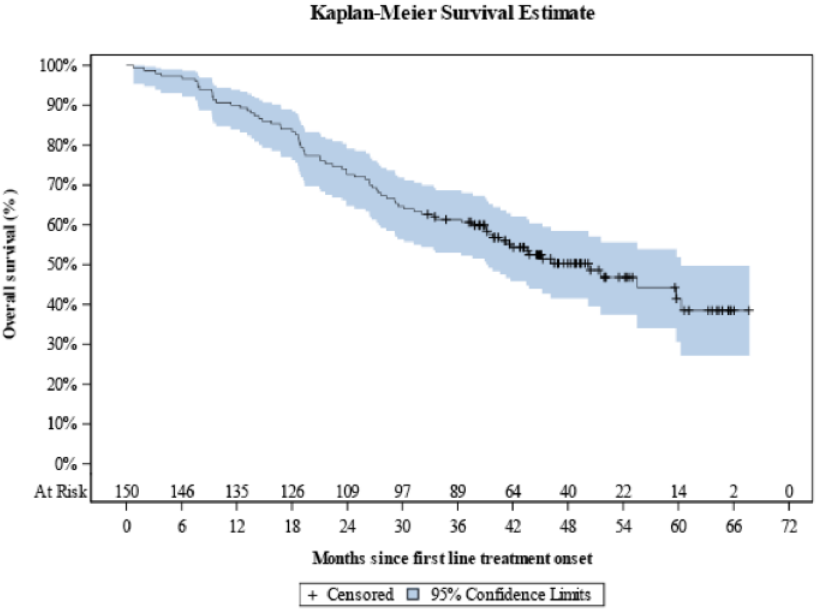
Figure 5. Kaplan-Meier overall survival curve since first-line treatment onset in the overall popula- tion.